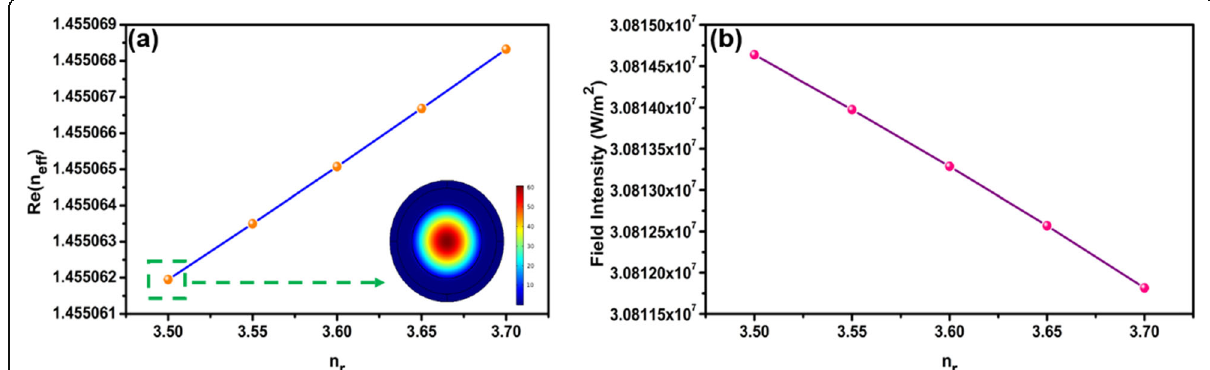
Fig. 15 a The mode real part of n eff versus n r for the four-layer WSe 2 nanosheet. And the inset is the electric field distribution of the mode with n